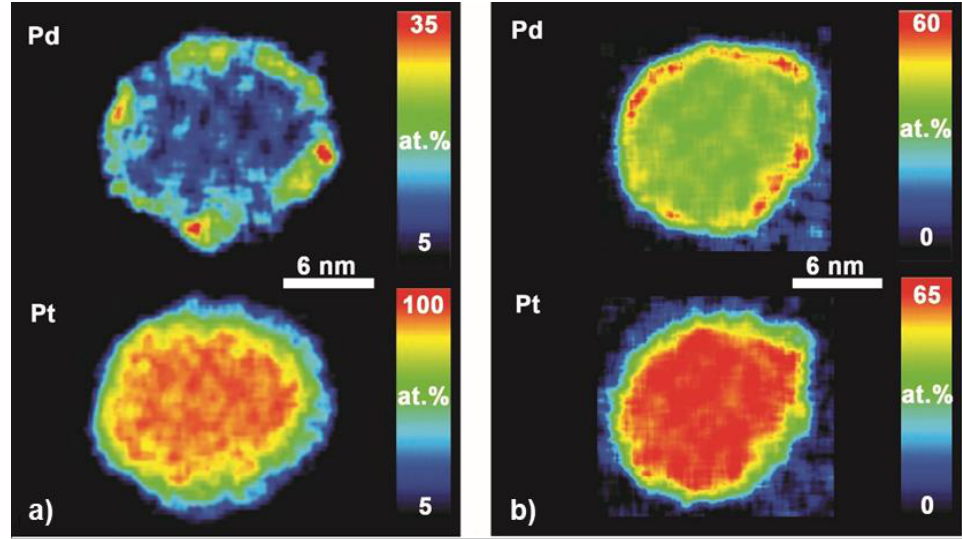
Figure A1. EDXS scan of Pt-Pd particles in the fresh state ( a ) and after aging for 1 h at 750 °C ( b ).